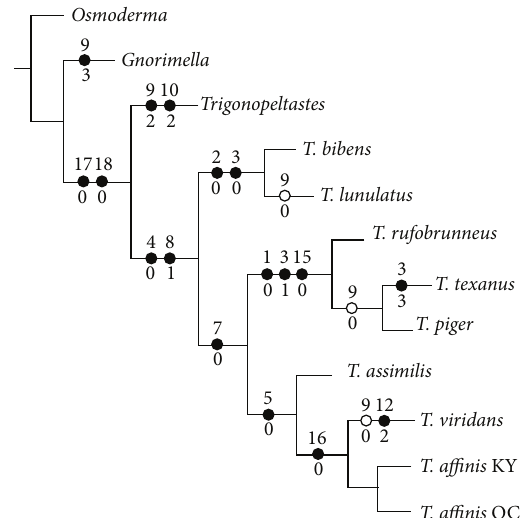
Figure 4: Topology based on morphological data from the par- simony analysis showing clade support (characters above and character states shown below). Solid black dots indicate character states without homoplasy. The Bayesian analysis of morphology was similar but much less resolved.